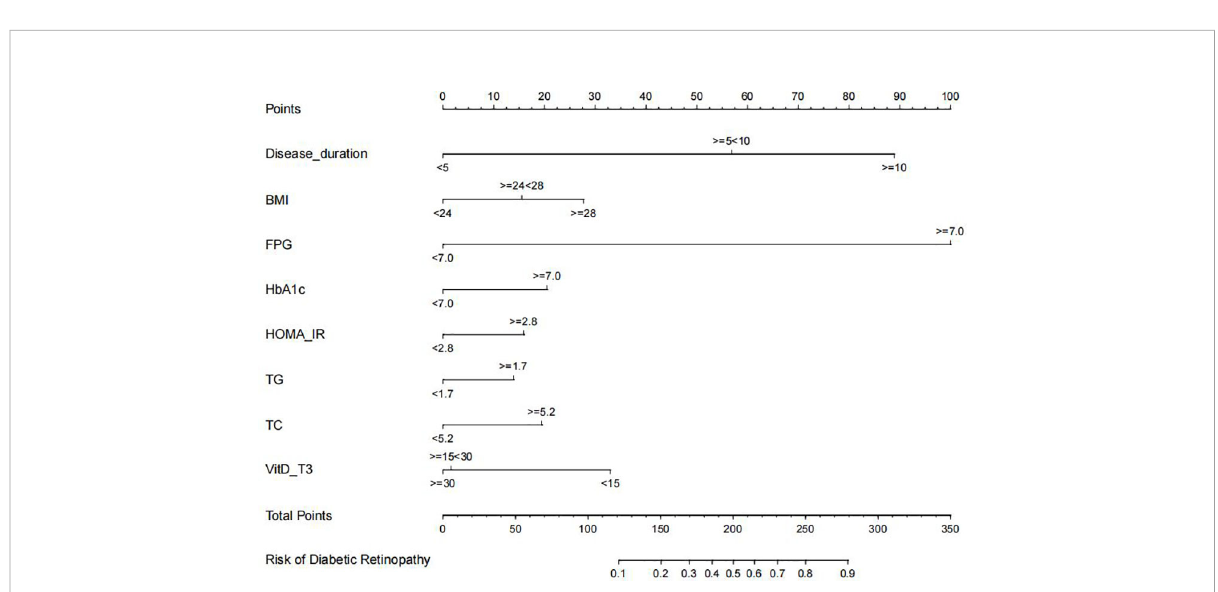
FIGURE 3 Diabetic retinopathy (DR) nomogram. The graph was created using data from the following sources: disease duration, body mass index (BMI), fasting blood glucose (FPG), glycated hemoglobin (Hb1Ac), homeostatic model assessment-insulin resistance (HOMA-IR), triglyceride (TG), total cholesterol (TC), and vitamin D